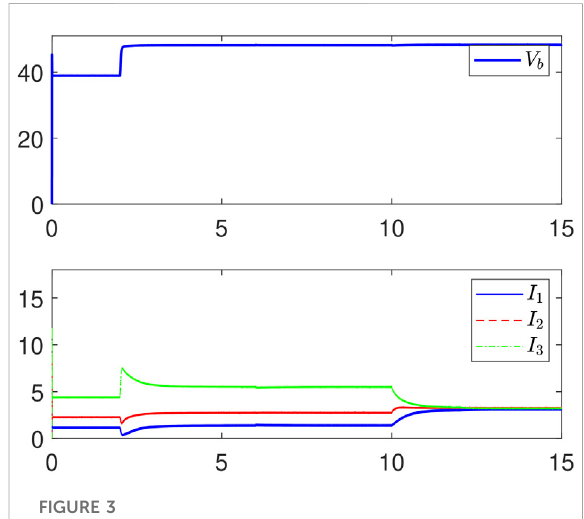
FIGURE 3 Trajectoriesofthevoltageandthecurrentwithloadaddedin.